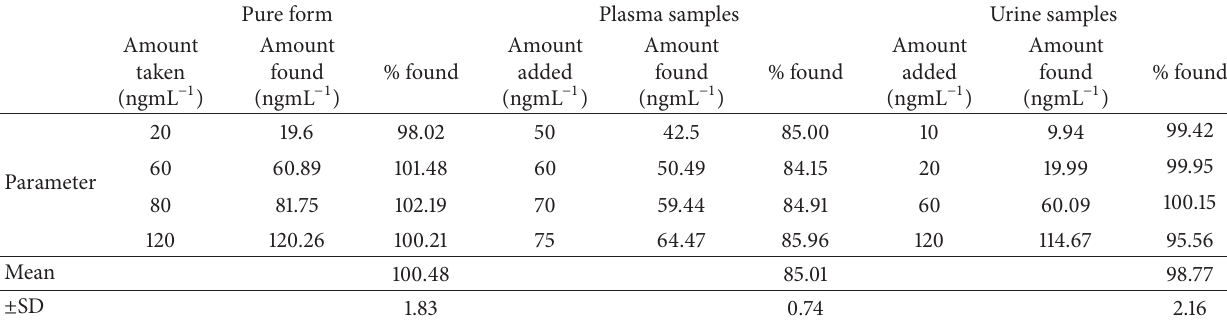
Table 6: Results of PTB determination in its pure form, human plasma, and human urine samples. Pure form Plasma samples Urine